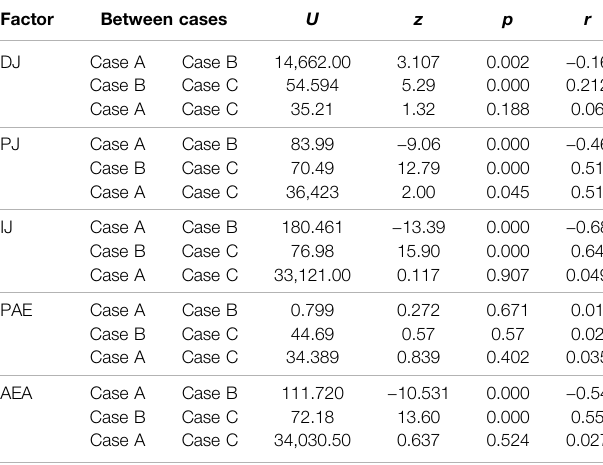
TABLE 9 | Cross case comparison using